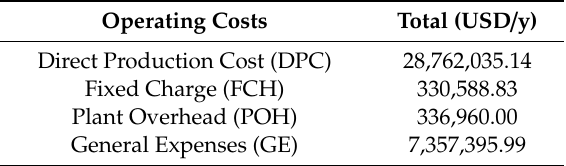
Table 5. The annual operating cost for the mass integrated approach for shrimp biorefinery.